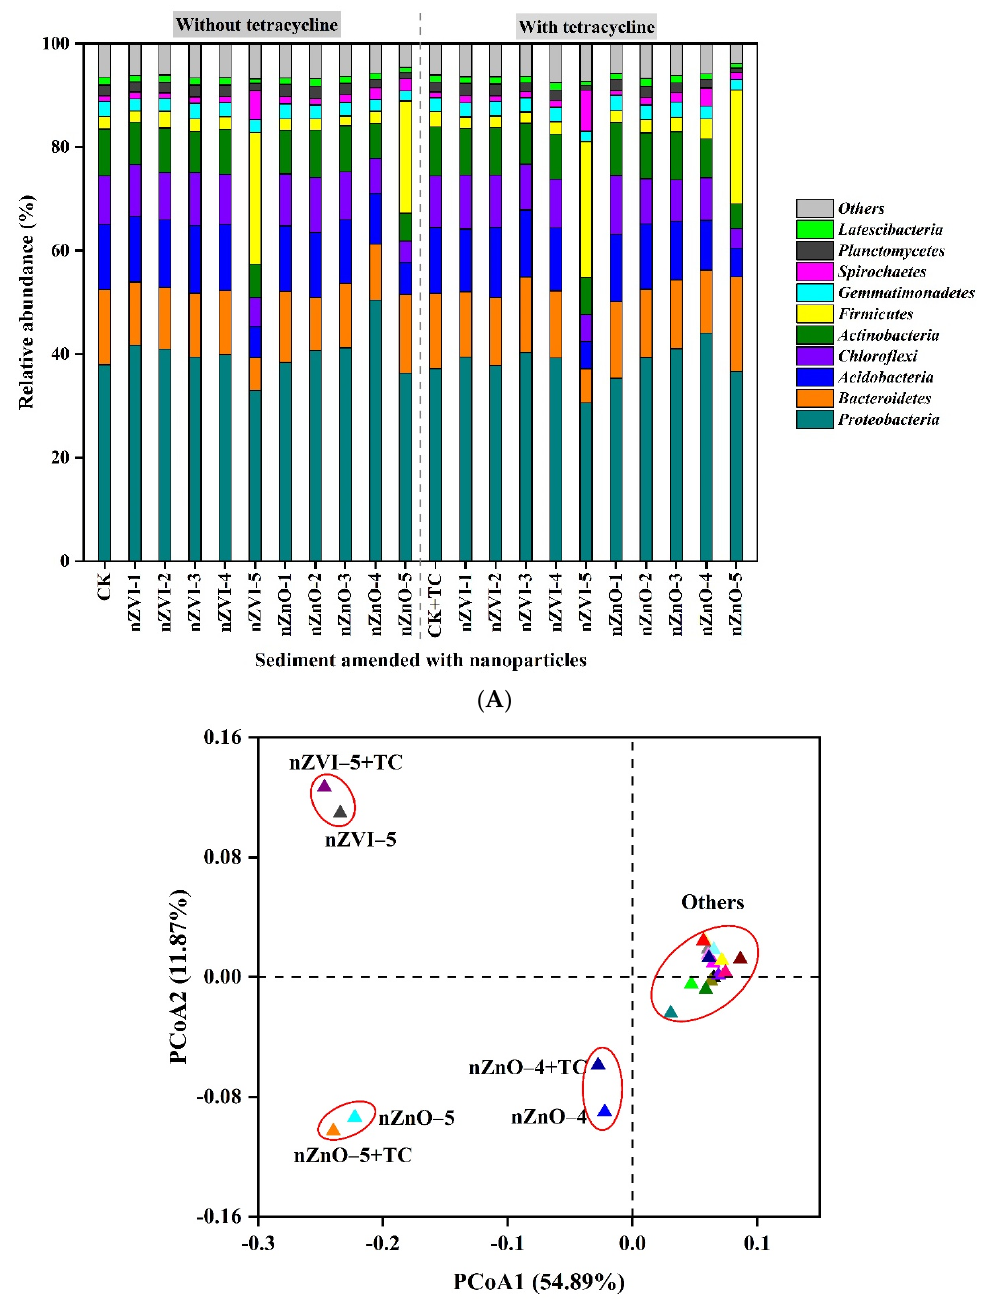
Figure 3. ( A ) Bacterial community composition at phylum level in nanoparticle-amended sediments. ( B ) PCoA analysis of bacterial communities under nanoparticles addition and coexistence of nanoparticles and tetracycline in sediment. Others include CK, CK, nZnO-1, nZnO-2, nZnO-3, nZVI-1, nZVI-2, nZVI-3, nZVI-4, and their counterparts in scenario 2 (+TC).